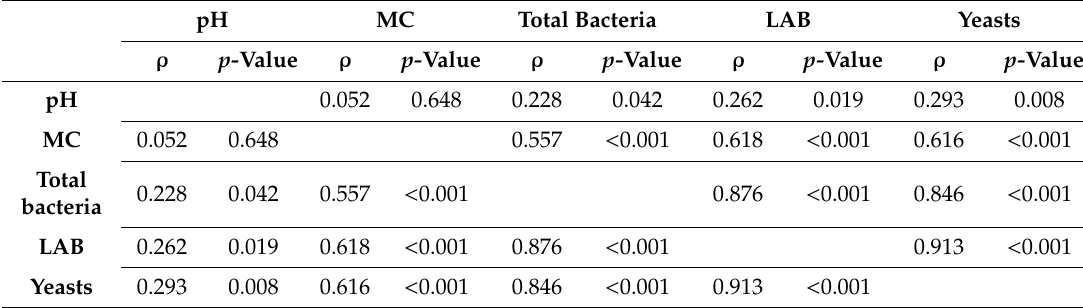
Table 2. Spearman´s correlation coe ffi cient ( ρ ) and its level of significance ( p -value) for the analyzed physicochemical and microbiological